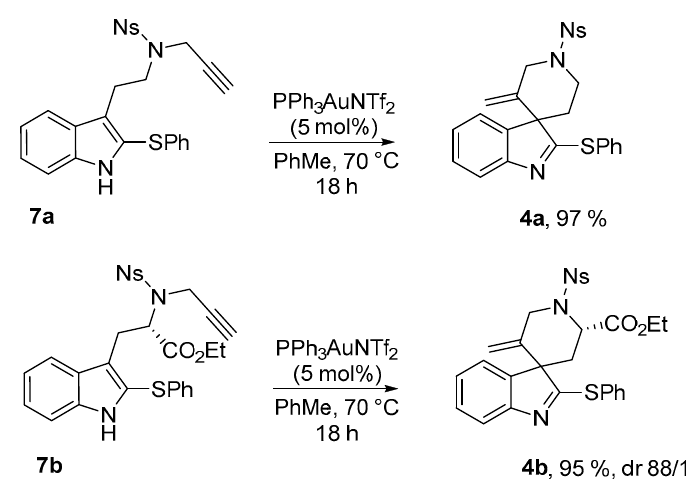
Figure 1. Structure of compound 4a (thermal ellipsoids set at 50% probability).